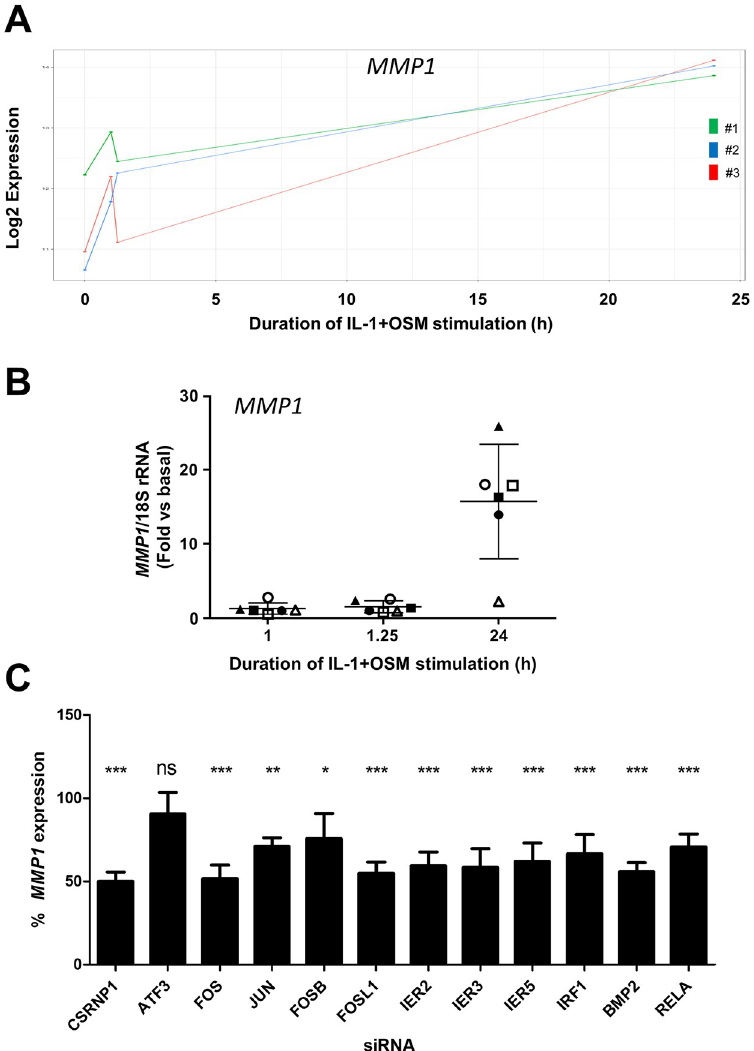
Fig 4. IL-1+OSM-induced MMP1 expression is maximal at 24 h post-stimulation. Human chondrocytes were treated with IL-1 (0.05 ng/mL) in combination with OSM (10 ng/mL) for the indicated time points and total RNA isolated. (A) RNA from three separate populations (#1, #2 and #3) was profiled using the Human HT-12v4 Expression Beadchip. The expression profile for MMP1 from the microarray dataset for each chondrocyte population is shown. (B) RNA from six separate chondrocyte populations was subjected to qPCR for MMP1 , and relative expression levels (normalized to 18S rRNA) at the indicated times determined. The plots show mean ± SD (n = 6). Data from the populations used in the microarray analyses are highlighted by the solid symbols (#1, ▲ ; #2 ■ ; #3, ● ). (C) Prior to stimulation with IL-1 (0.05 ng/ml) in combination with OSM (10 ng/ml), human chondrocytes were transfected with siRNA specific for the indicated genes, or a non-targeting control (siCon; all 100 nM), and mRNA expression levels (mean ± S.D., n = 6) of MMP1 measured 24 h post-stimulation by qPCR, relative to siCon treated cells, normalized to 18S rRNA. Statistical comparisons are versus IL-1 + OSM + siCon (Student’s two-tailed unpaired t test), where ��� , p < 0.001; �� , p < 0.01; � , p < 0.05; ns = not significant. The data are pooled from three separate experiments, each using chondrocyte cultures from different